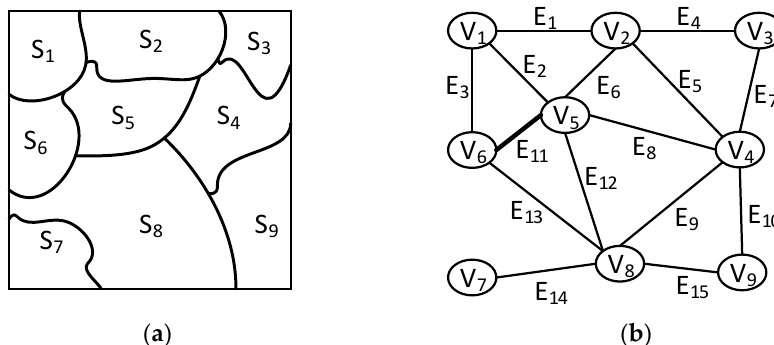
Figure 10. An example of RAG: ( a ) The stetch map of superpixels distribution; ( b ) The corresponding RAG.